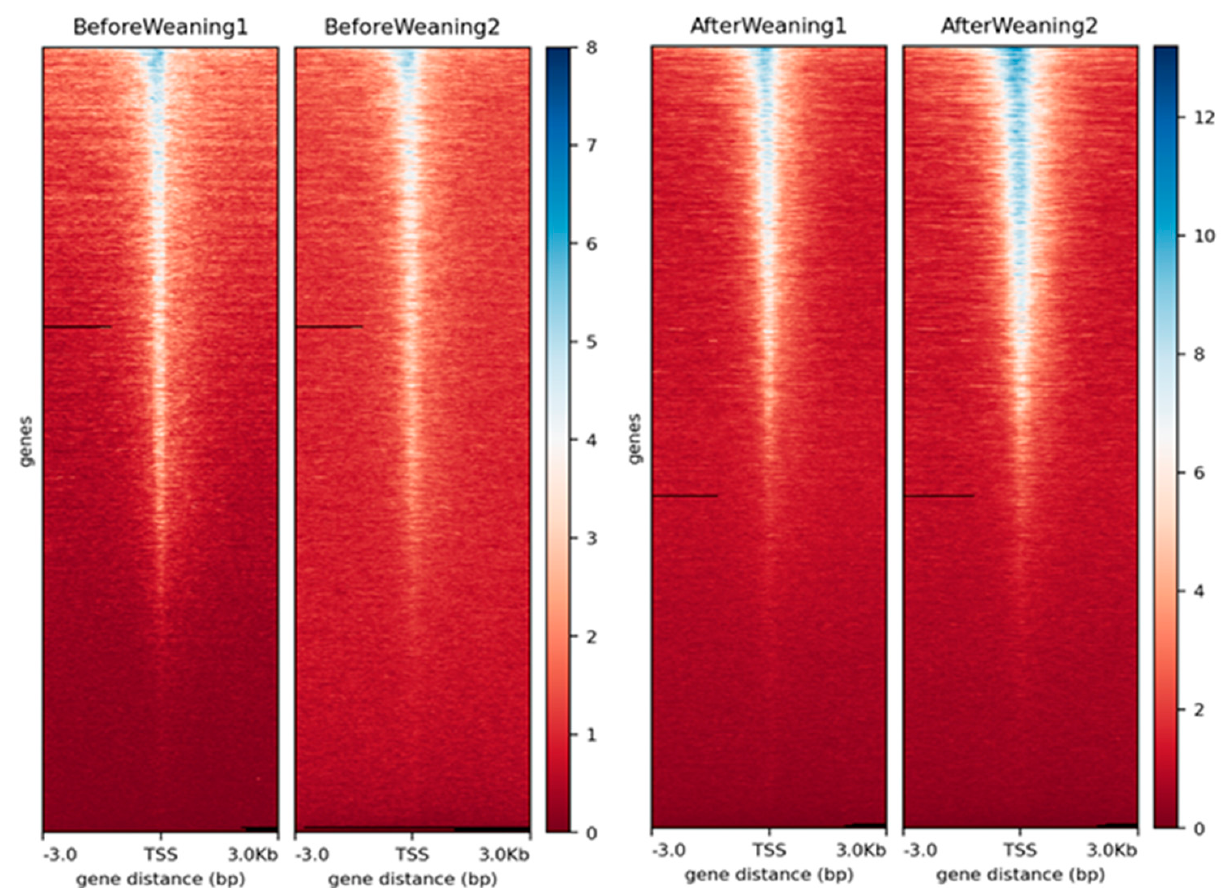
Figure 1. Heatmap profile of peaks relative to the transcription start sites (TSS) considering ±3 kb regions for each replicate in the weaning conditions (considering chromosomes 1–29). The blue color intensity reflects the level of peak enrichment. Each condition has two biological replicates.